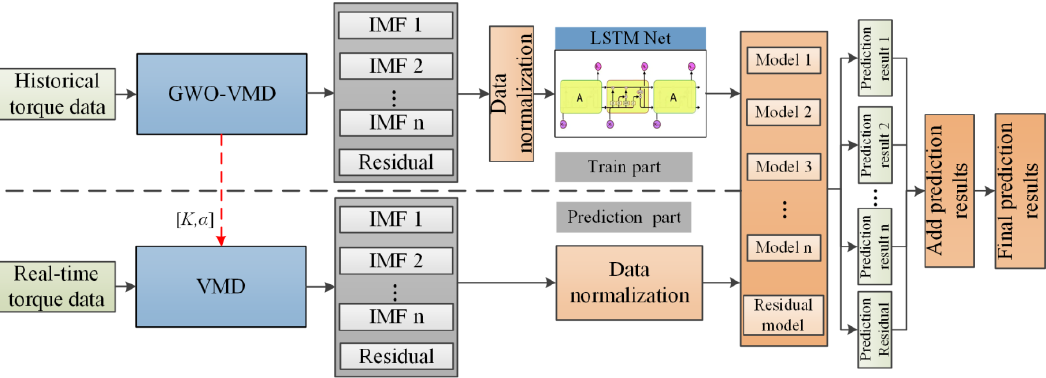
Figure 6. GWO-VMD -LSTM prediction model.